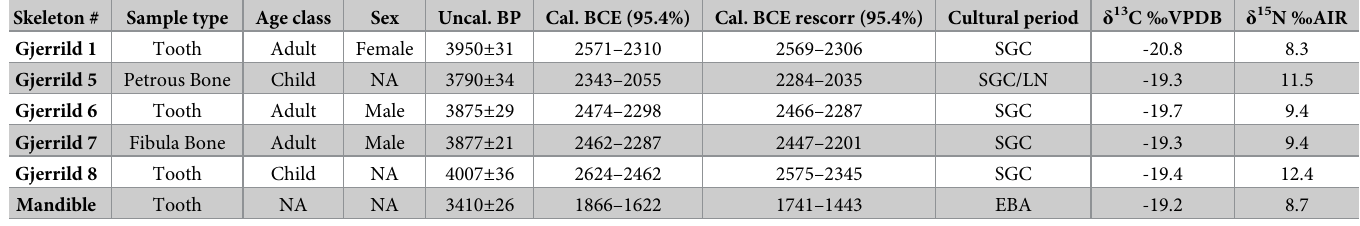
Table 1. Sample information, 14 C dates and isotope